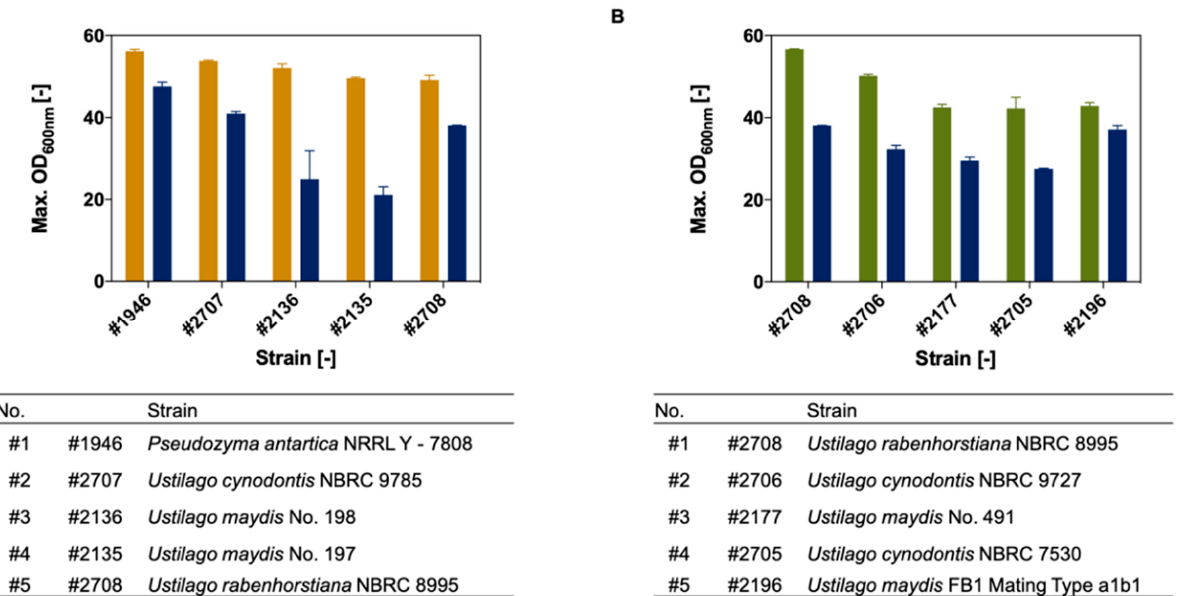
Figure 3. Maximum growth of best Ustilaginaceae candidates obtained from biodiversity screening. ( A ) The top 5 Ustilaginaceae candidates using acetate as a co-substrate (orange). #2707, #1946, and #2708 obtained the highest growth using 2.5 g L − 1 acetate whereas #2135 and #2136 obtained the best results using 10 g L − 1 acetate. ( B ) The top 5 Ustilaginaceae strains using 2.5 g L − 1 formate as a co-substrate (green). Growth Profiler 24-deep-well plate cultivation was performed in MTM medium with 4 g L − 1 NH 4 Cl. Respective glucose references (20 g L − 1 ) are shown in blue. Error bars indicate the deviation from the mean for n = 2.